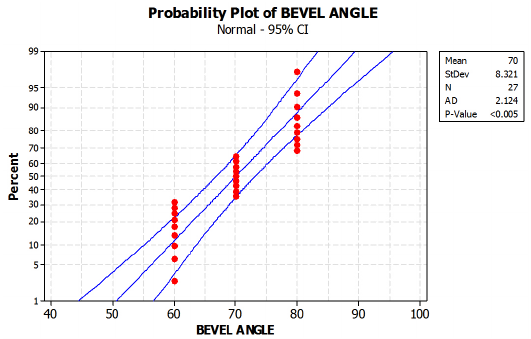
Figure 7. Probability plot of Bevel